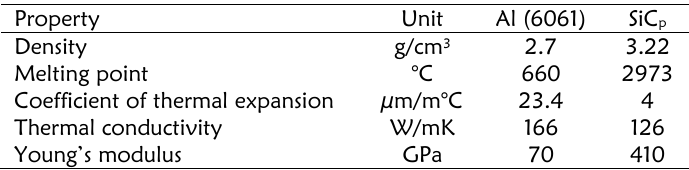
Table 1. Properties of matrix (AA6061) and reinforcing (SiC p )